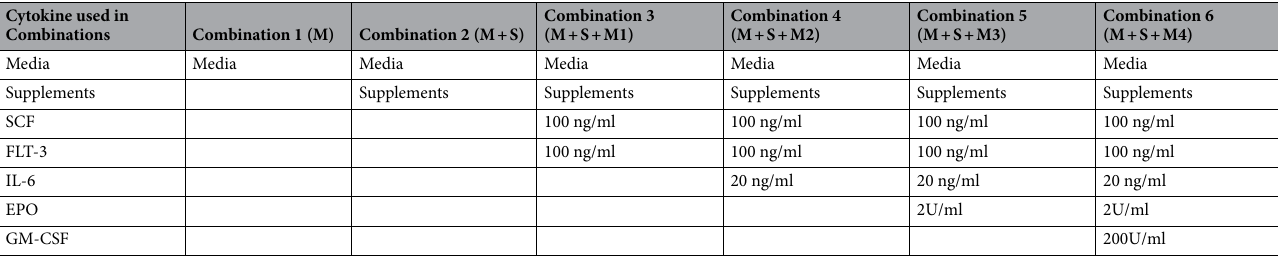
Table 1. Combinations of Cytokines used for expansion of fetal liver hematopoietic stem and progenitor cells. M = Media, S = Supplements, M1 = SCF + Flt-3, M2 = SCF + Flt-3 + IL6, M3 = SCF + Flt-3 + IL6 + EPO, M4 = SCF + Flt-3 + IL6 + EPO +